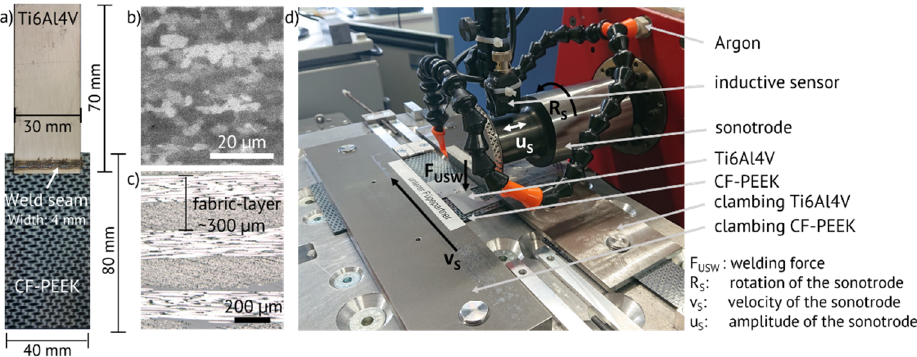
Figure 3. ( a ) Ti6Al4V/CF-PEEK joints of preliminary welding experiments and the microstructure ( b ) of a Ti6Al4V sheet, ( c ) of a CF-PEEK sheet and ( d ) the setup for planar ultrasonic welding.